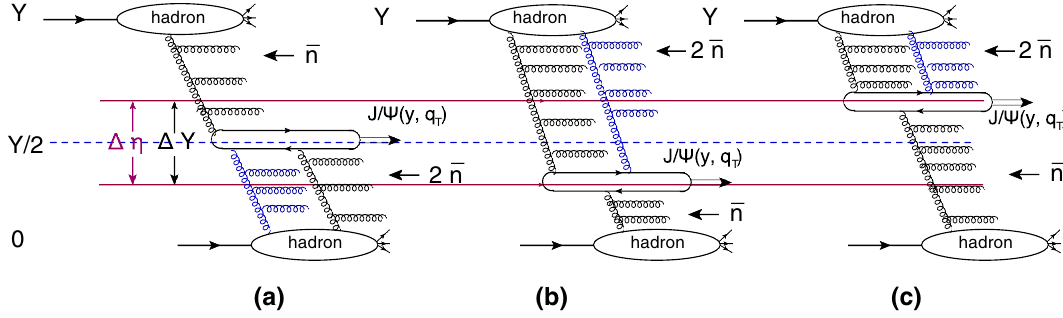
Fig. 5 In the case when the quarkonia and charged particle bins over- lap, the observed enhanced multiplicity cannot be attributed either to single-pomeron or to double-pomeron yields, for this reason we have